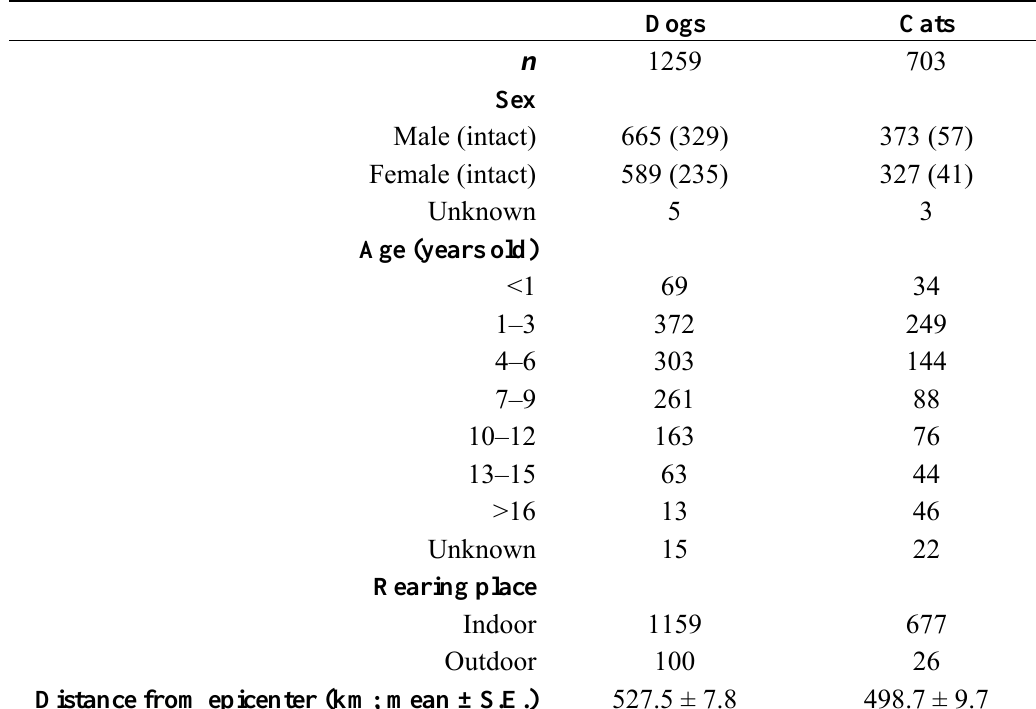
Table 2. General characteristics of the